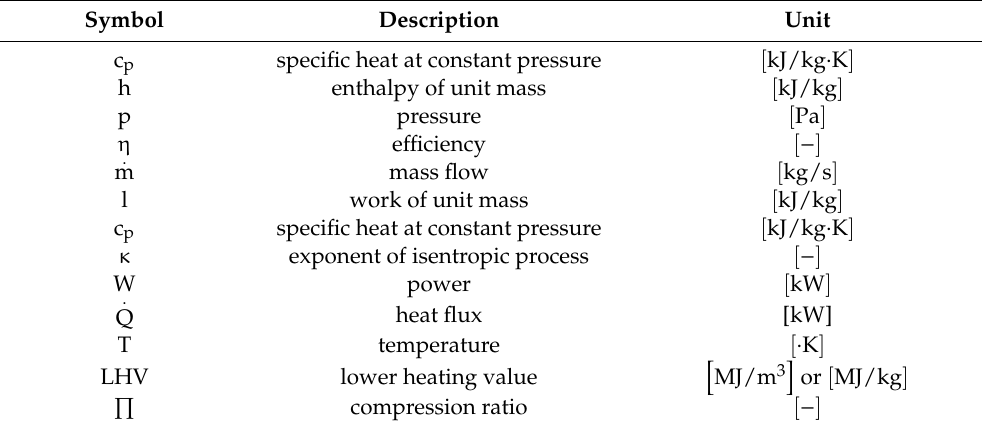
Table 1. Symbols and units used in calculations.